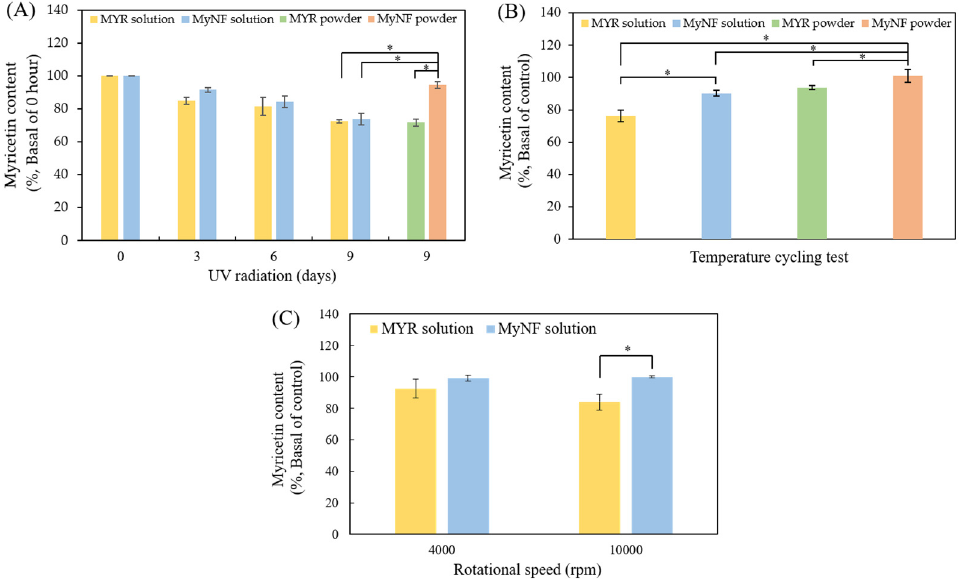
Figure 7. The stability test of photostability, thermostability, and centrifuge testing of MYR and MyNF (1:20:12). ( A ) The photostability of MYR solution, MyNF solution, MYR powder, and MyNF powder at 0 to 9 days of UV irradiation. ( B ) The thermostability of MYR solution, MyNF solution, MYR powder, and MyNF powder were tested at − 20 °C, 4 °C, 25 °C, 50 °C, and 65 °C in sequence, each temperature for 24 h. ( C ) The centrifuge testing of MYR solution and MyNF solution, respec- tively, at 4000 and 10,000 rpm for 10 min. The values represent the mean ± SD ( n = 3). * p < 0.05 was regarded as statistically significant.